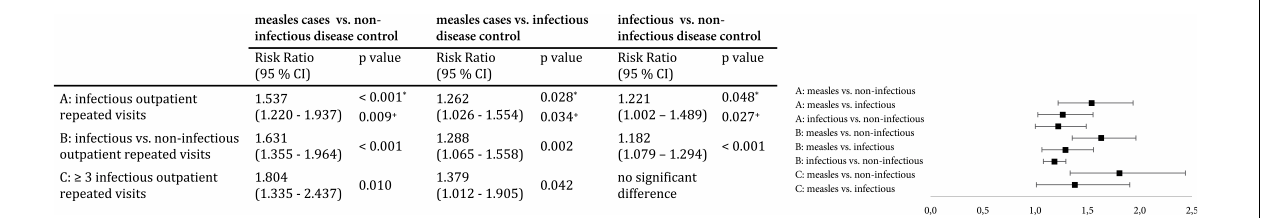
Frontiers in Pediatrics |